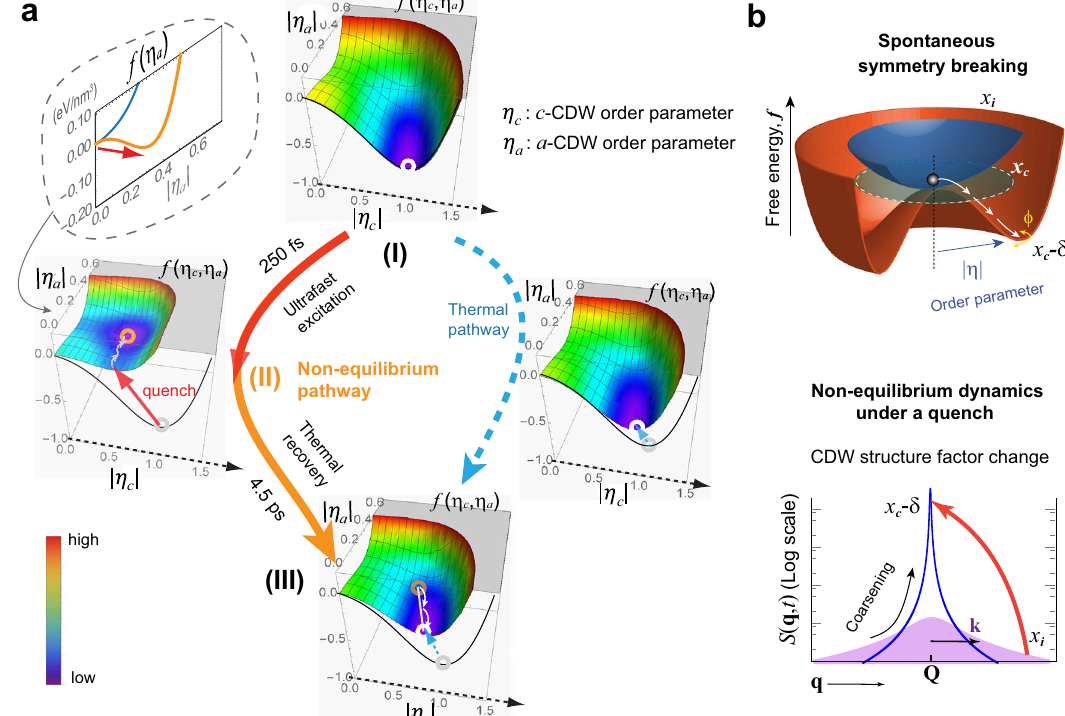
Fig. 2 Landau – Ginzburg model for nonthermal and thermal CDW phase transitions. a , The two-dimensional free-energy landscape for photoinduced phase transition modeled after the experiment condition at F = 1.85 mJ/cm 2 . The nonequilibrium pathway (depicted in the left route) involves the formation of a bi-directional hidden state when the repulsive coupling potential is suppressed by a swift reduction of the pre-eminent order parameter | η c | . In contrast, in the thermal pathway (right) the global free energy minimum remains in the condition where | η a | = 0, namely the CDW is uniaxial. b Symmetry-breaking process probed using ultrafast electron scattering. The upper panel shows the free energy unfolding in the order parameter fi elds of the charge-density wave involving amplitude (| η |) and phase ( ϕ ) degrees of freedom. In a thermal process, the order parameter amplitude grows in response always to the unfolding landscape across the critical point x c . The lower panel shows the scattering pro fi le changes after a rapid quench across x c